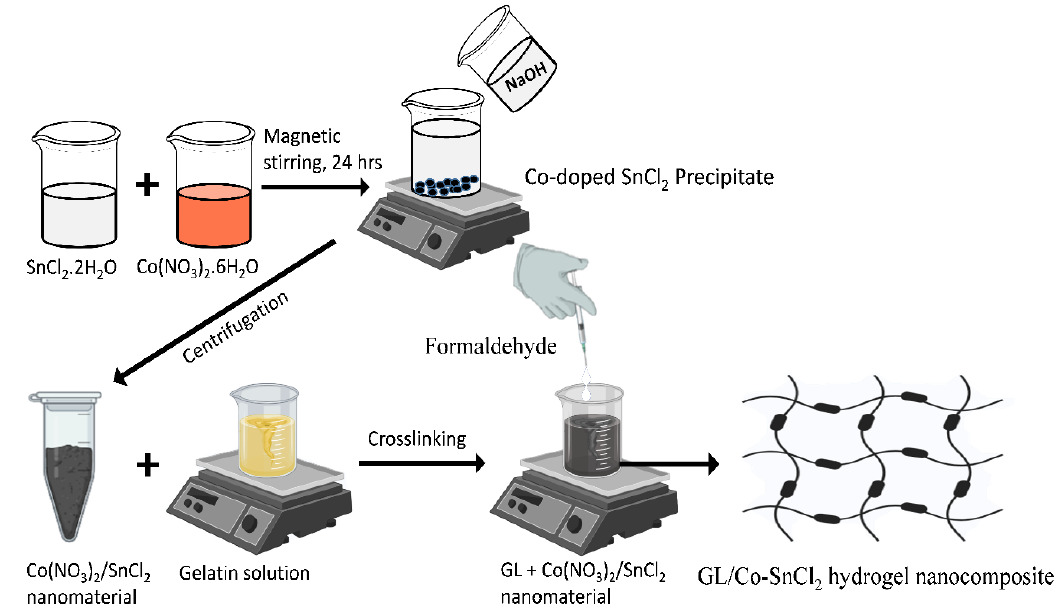
Figure 10. Preparation of GL/Co-SnO 2 hydrogel nanocomposite materials.